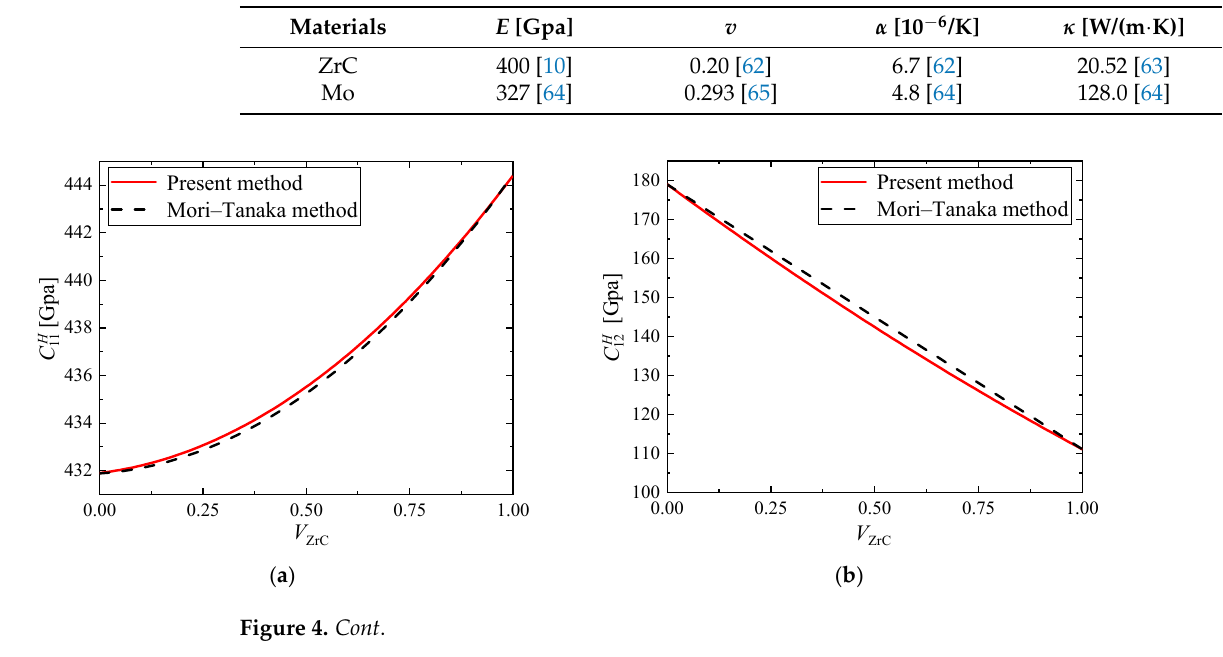
Table 1. The elastic modulus E , Poisson’s ratio v , thermal expansion coefficient α and thermal conductivity coefficient κ of materials at room temperature (25 °C).